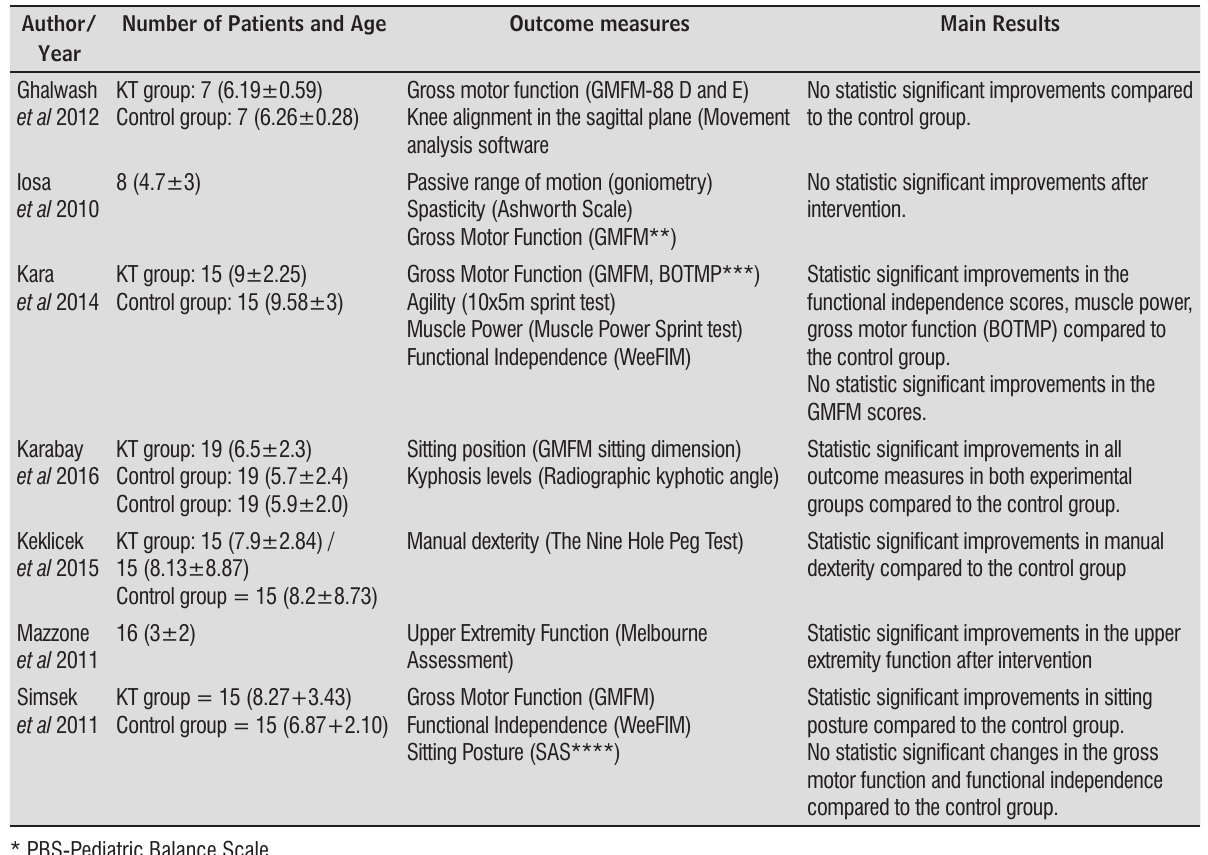
Table 2 - Patient Characteristics, Outcome Measures, and Main